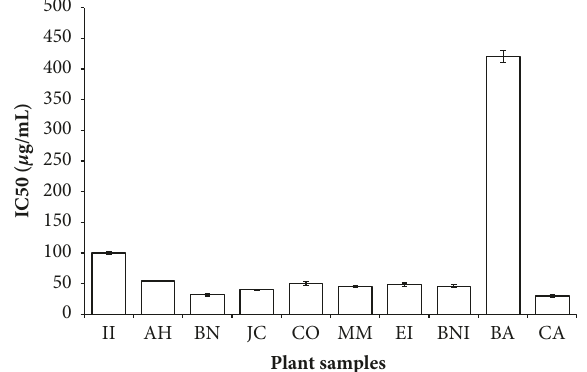
Figure 5: ABTS free radical scavenging activity of selected plant extracts used in the management of oral and skin infections in southeast folklore medicine of Nigeria. II, Ipomoea involucrata ; AH, Acalypha hispida ; BN, Breynia nivosa ; JC, Jatropha curcas ; CO, Chromolaena odorata ; MM, Macrolobium macrophyllum ; EI, Eleusine indica ; BNI, Baphia nitida ; BA, Burkea africana ; CA, Cassia alata